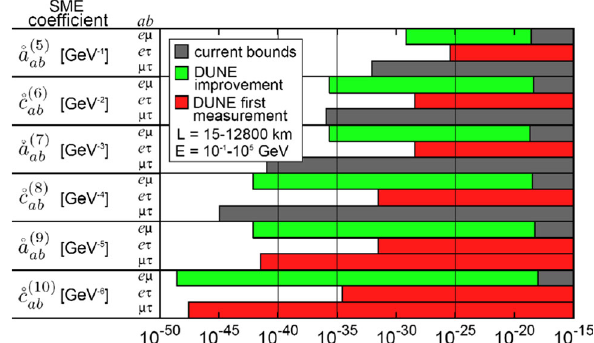
Fig. 11 DUNE sensitivity to the atmospheric angle for neutrinos (blue), antineutrinos (red), and to the combination of both under the assumption of CPT conservation (black)